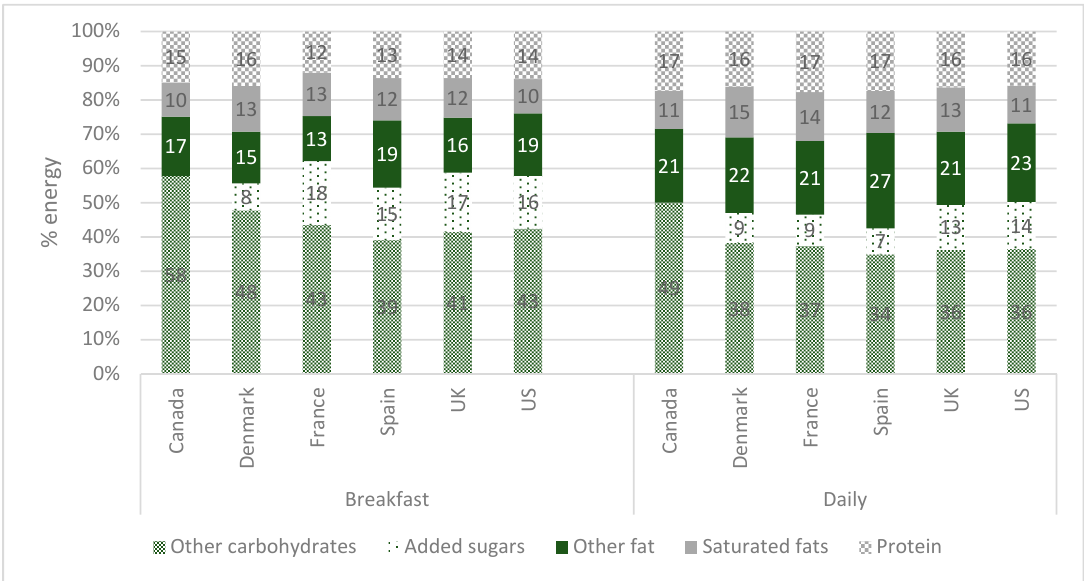
Figure 3. Macronutrient profiles (% energy contributions) of breakfast and daily intakes among regular breakfast consumers, in the total survey populations. Added sugars intake data were not available for Canada; thus “other carbs” are total carbohydrates in the Canada bar.